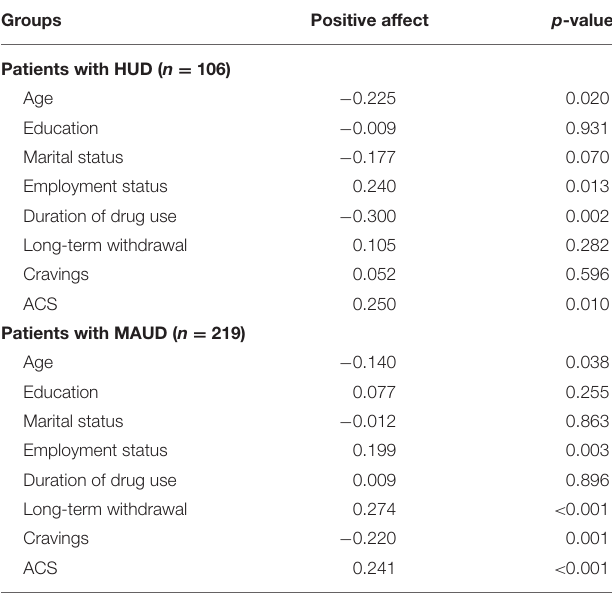
TABLE 3 | Correlation between clinical variables and positive affect in the two groups of